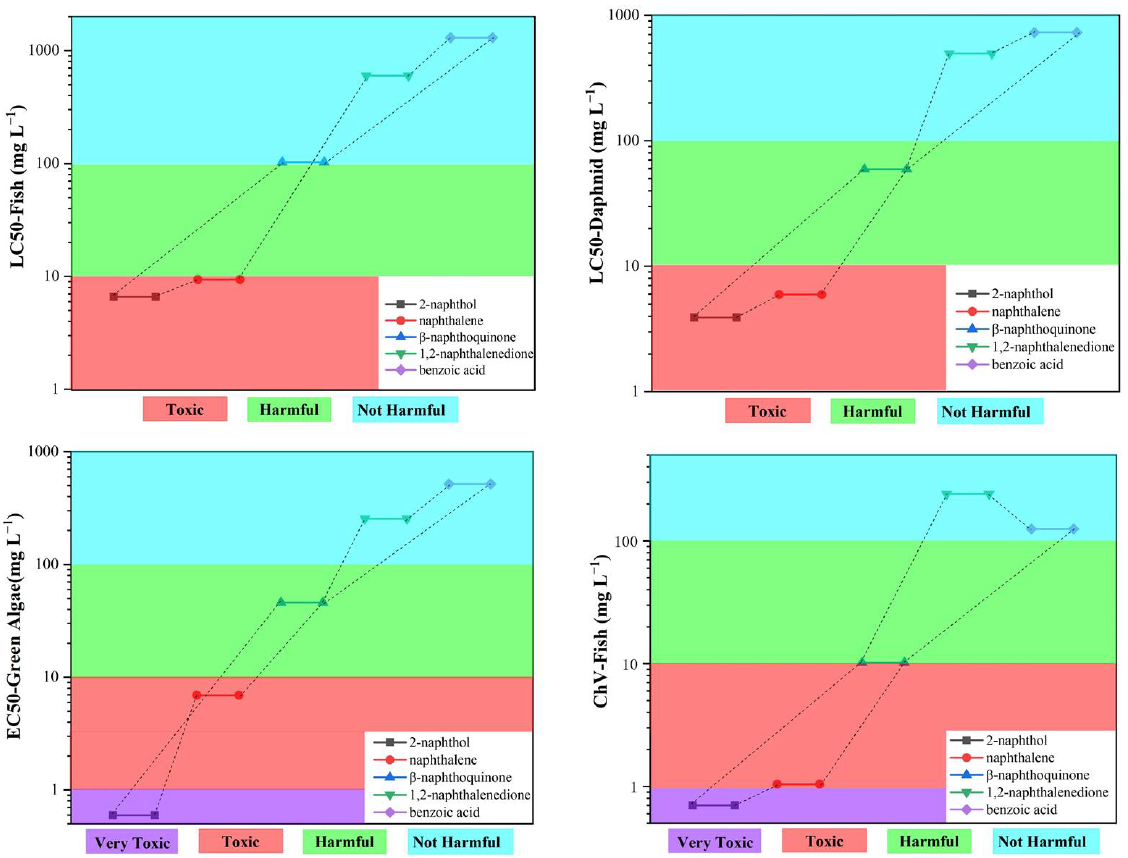
Figure 11. The toxicity of 2-naphthol degradation products.